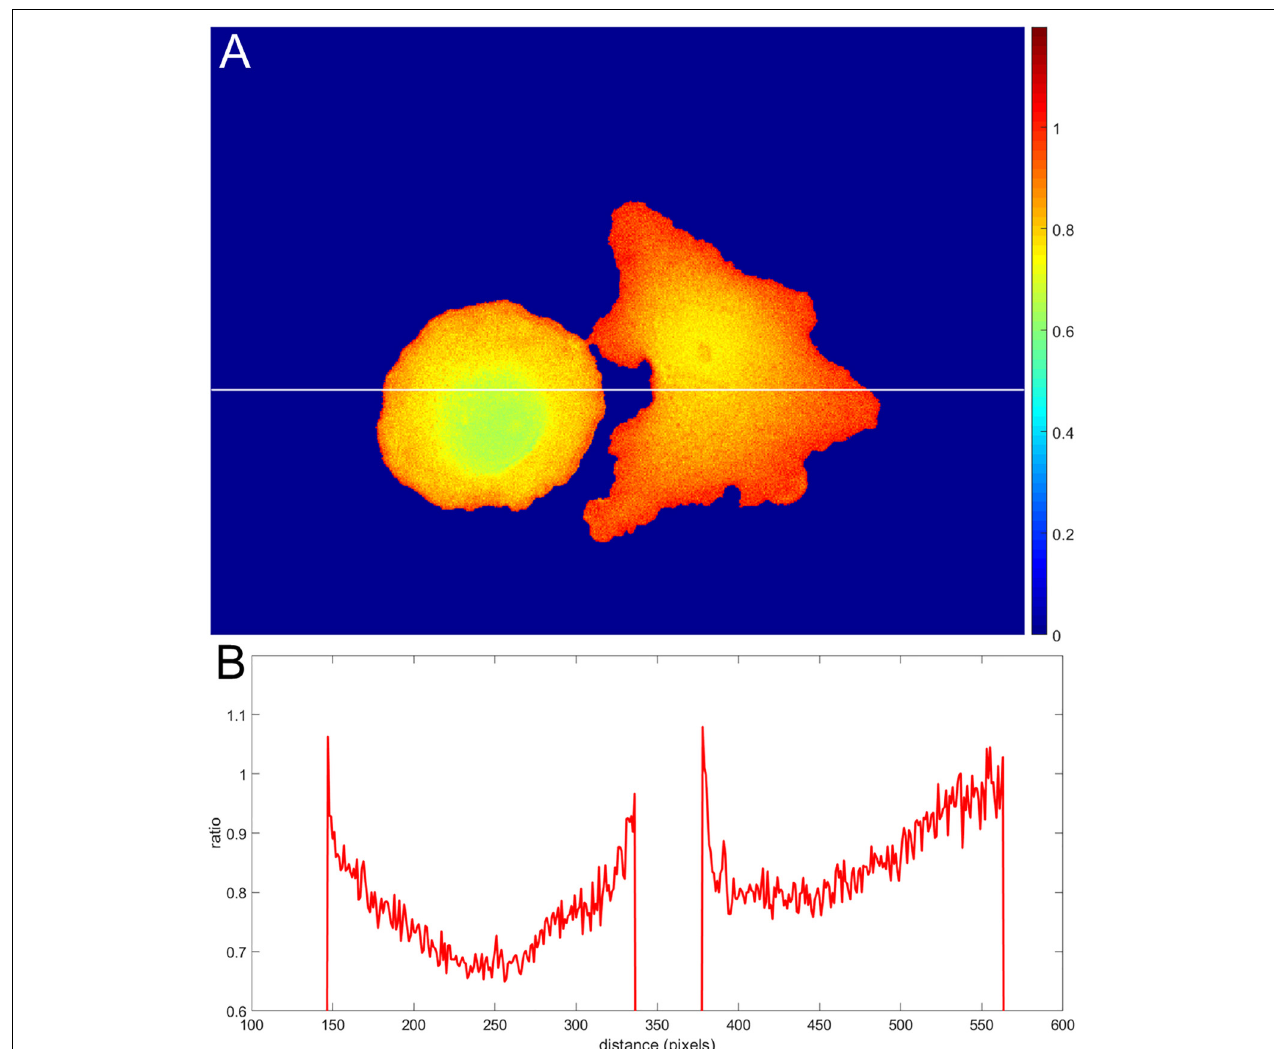
FIGURE 2 | Illustration of an extreme case of an error in background subtraction. (A) The ratio m Cerulean C yPet without background subtraction at all. (B) The ratio profile from panel (A) along the white